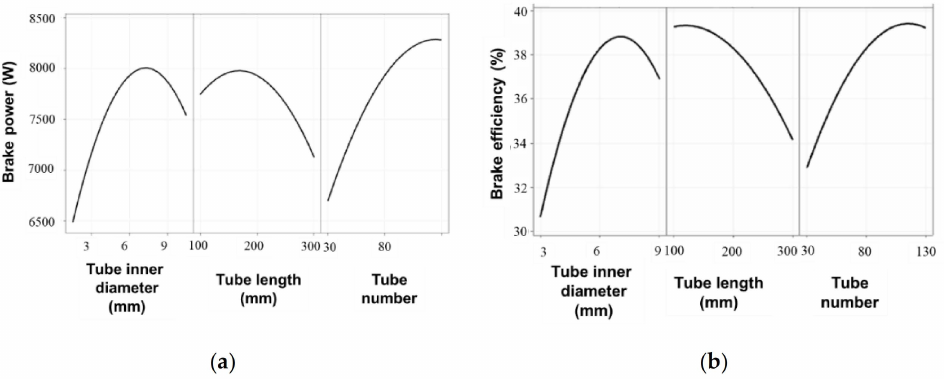
Figure 10. Variation of ( a ) the brake power and ( b ) brake efficiency according to the design factors of the tube inner diameter, tube length, and number of tubes.